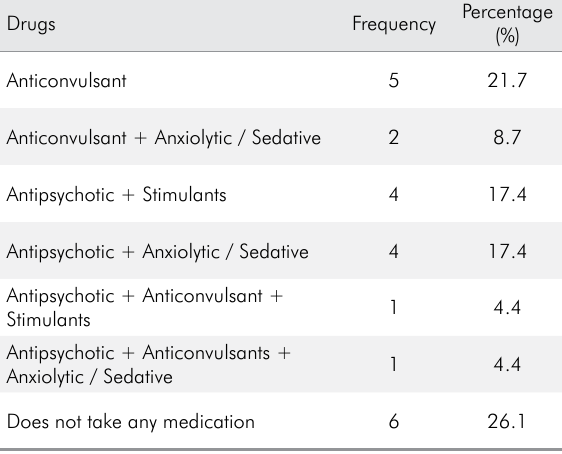
Table 4. Frequency of use of controlled psychotropic drugs by FXS